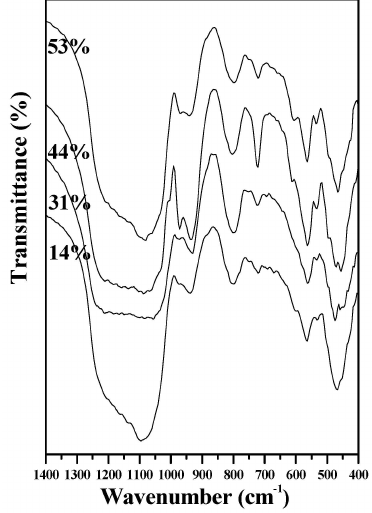
Figure 5. FTIR patterns of various surfactant concentration treated MBG particles immersed in SBF for 1